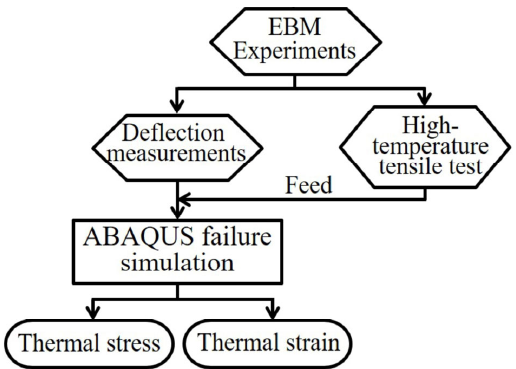
Figure 1. A flowchart of the experimental and simulation works applied in this research.